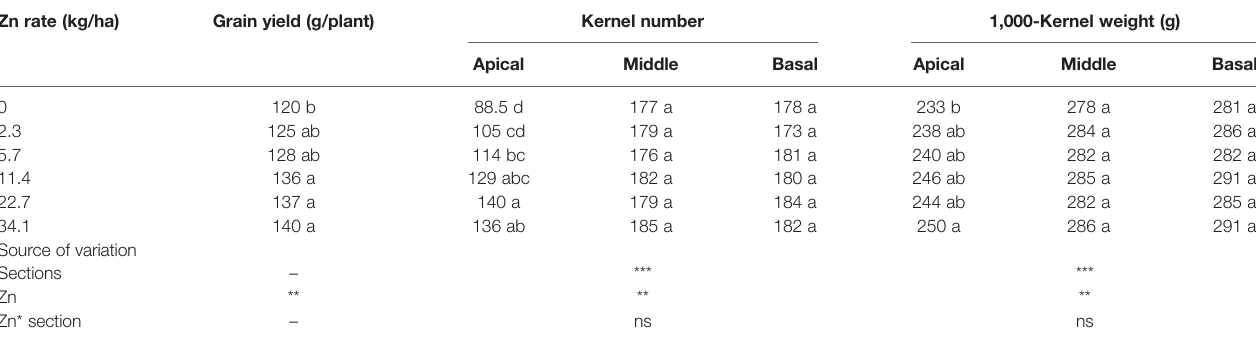
TABLE 1 | Effects of Zn various application rates on grain yield, kernel number per spike, and 1,000-kernel weight of the apical, middle, and basal sections of maize spikes under fi eld conditions. Zn rate (kg/ha) Grain yield (g/plant) Kernel